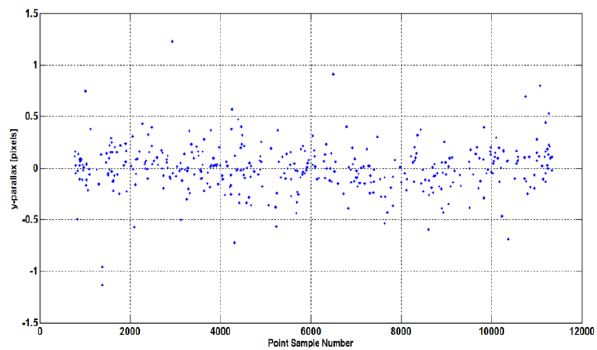
Figure 5: Scatter pattern of y-disparities obtained by the LSM